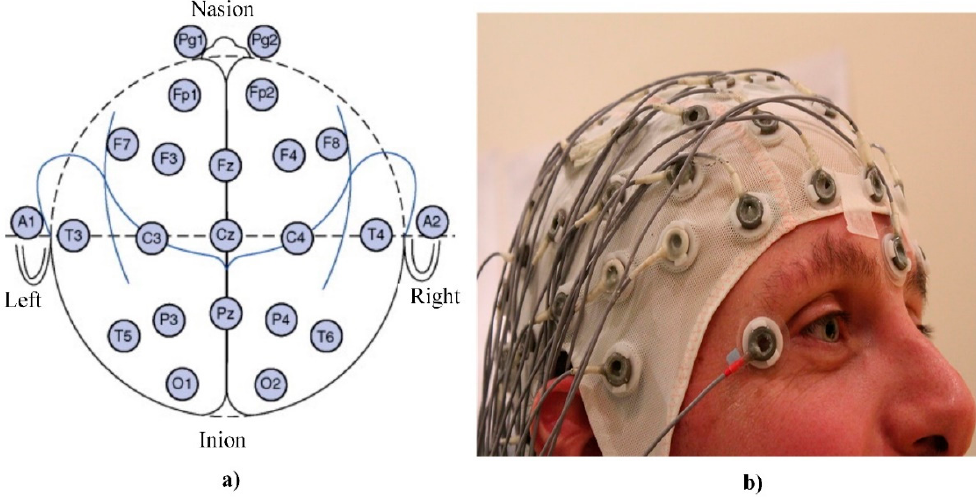
Figure 2. Electroencephalography (EEG) measurements: ( a ) distribution of EEG electrodes on human scalp [39]; ( b ) special headset with installed electrodes [40].